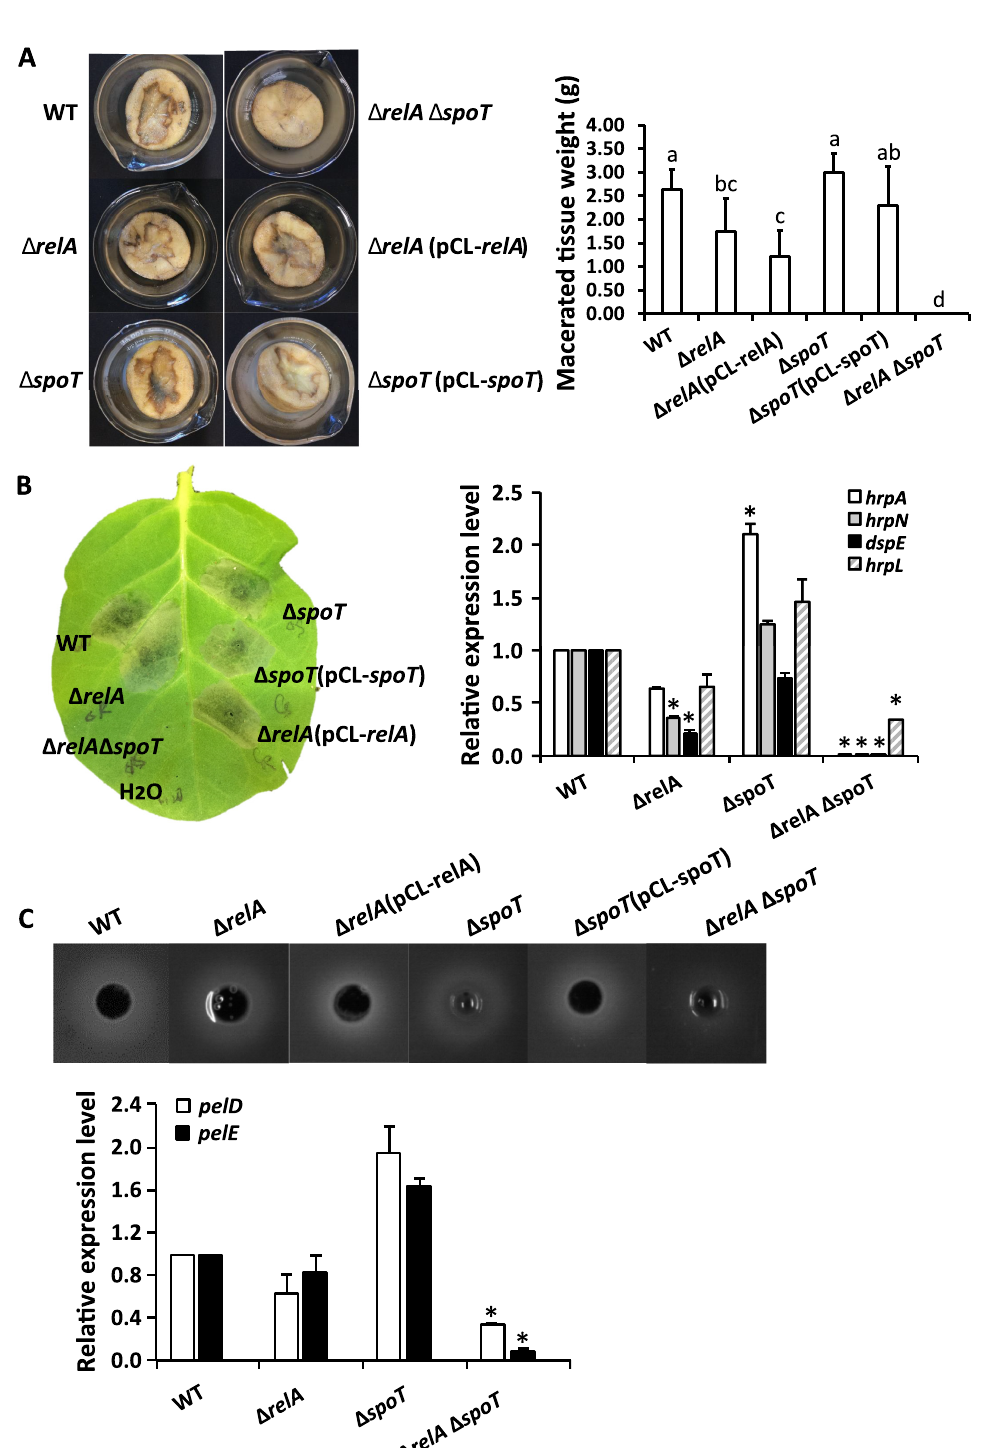
Fig 7. Impact of ppGpp on virulence in D . dadantii . Disease symptoms and quantification on potato tuber (A), hypersensitive response (or induced cell death) on tobacco leaf and expression of T3SS genes in hrp- inducing minimal medium (B), and Pel production and expression of pel genes (C) in wild type, ppGpp biosynthesis mutants, and the complementation strains. The pathogenicity assay was performed on potato tubers in the absence of free-standing water, with symptoms documented at 18 hpi; the hypersensitive response was performed by infiltrating the bacterial suspension